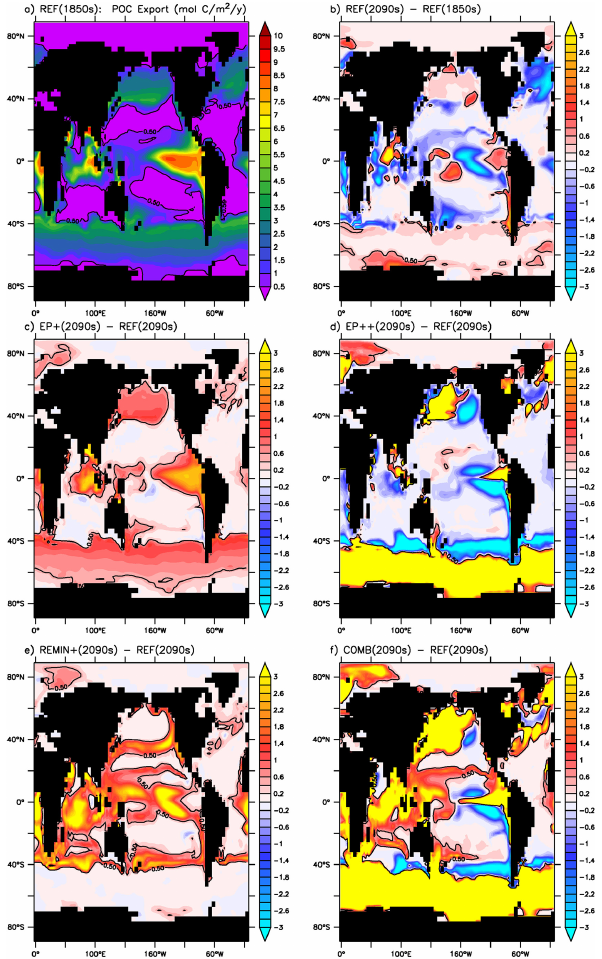
Figure 9. Dissolved oxygen (mmolm − 3 ) at 500m for (a) REF in 1850; (b) the change in 2090–2099 mean for REF relative to (a) . For the 2090–99 mean, the change relative to REF for (c) EP+; (d) EP++; (e) REMIN+; (f) COMB